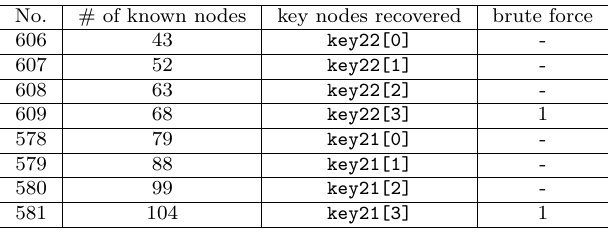
Table 9: Attack on SPECK found by TADA (considering obtaining 7 bits as successful attack) - Each row corresponds to a vulnerable instruction with sequence number “No.” such that after the attack on this instruction, the number of known nodes is given by “# of known nodes” and the key nodes that are retrieved are given by the third column, in case only 7 bits of the target node are obtained, the brute force complexity is indicated by 1.